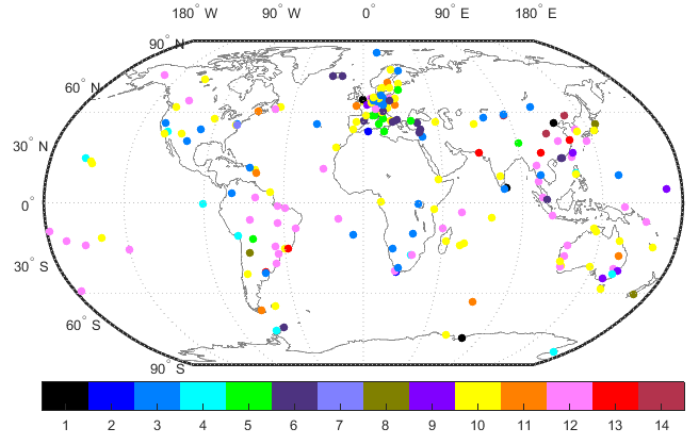
Figure 1. Overview of the experimental multi-GNSS experiment (MGEX) and International GNSS Monitoring and Assessment System (iGMAS) stations. Different colors denote receivers from different manufacturers corresponding to the first column in Table 3.